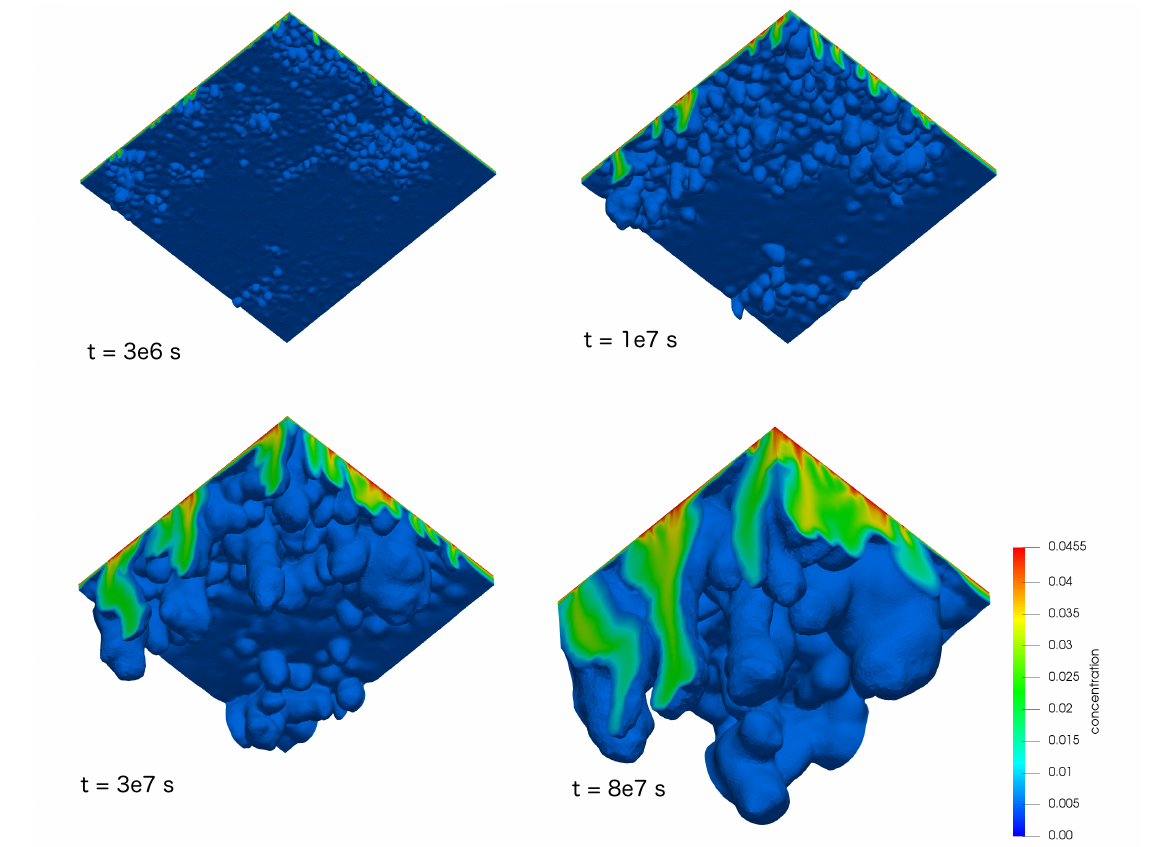
Figure 9. Evolution of convective mixing in the heterogeneous fractional Lévy motion model (permeability heterogeneity illustrated in Figure 4. Time in